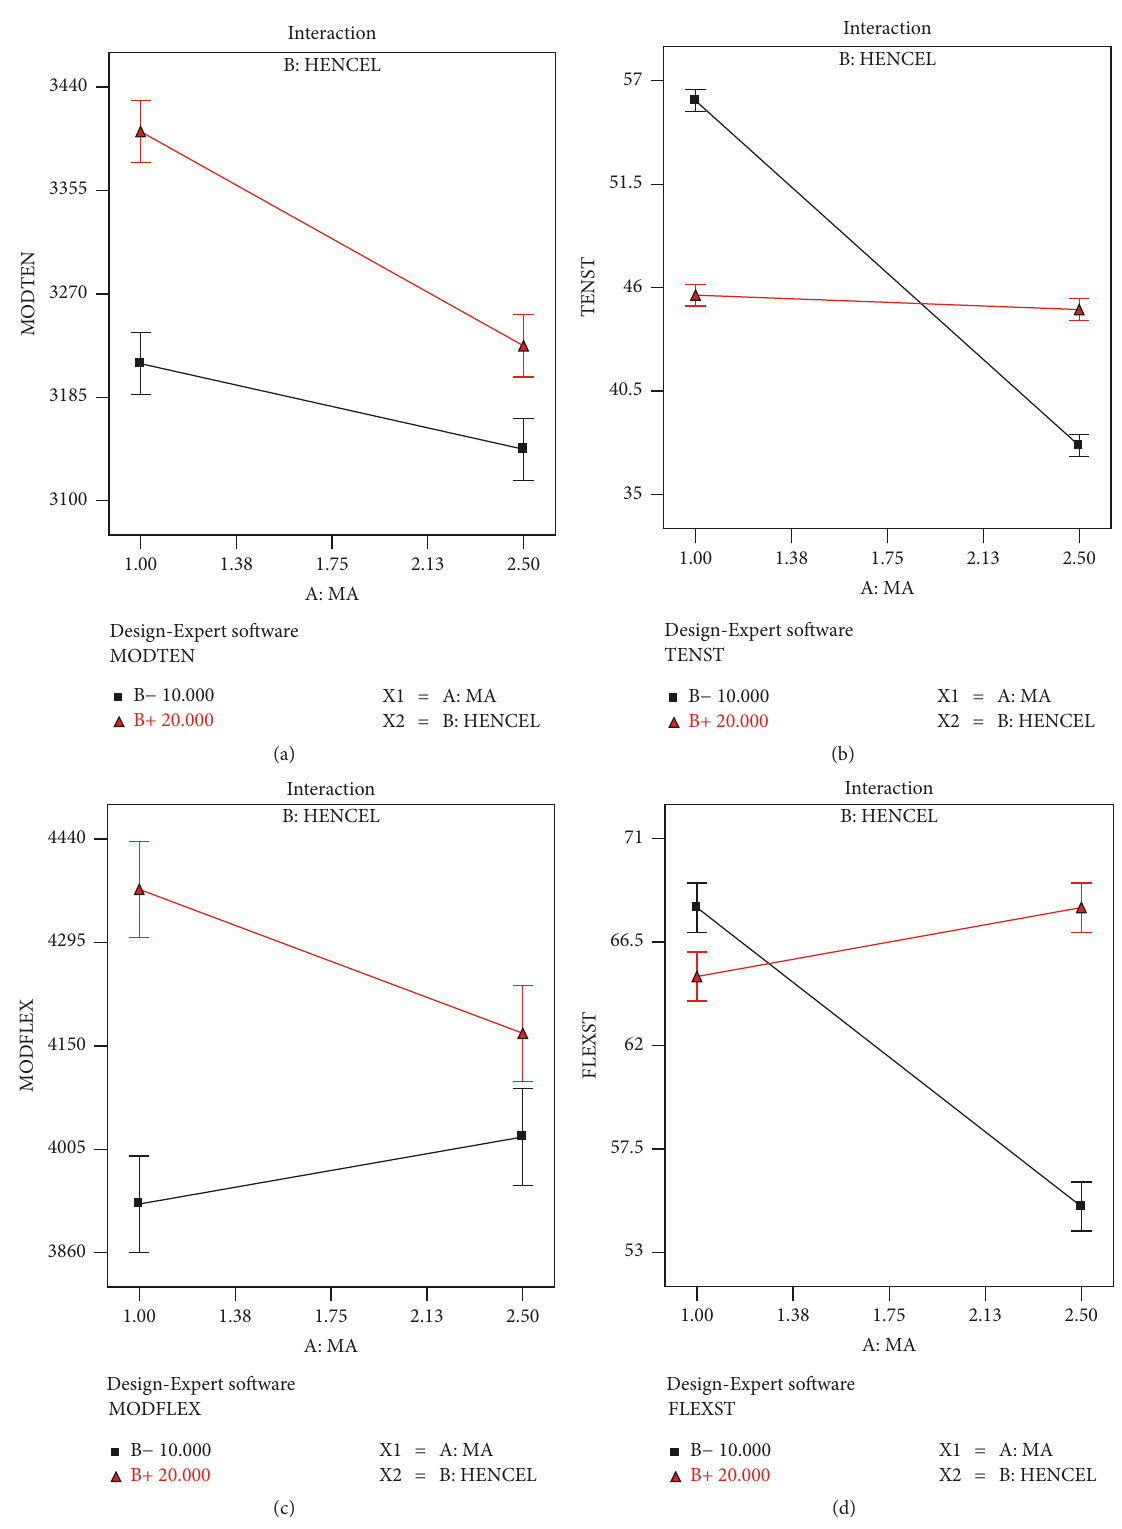
Figure 9: Interaction plots for tensile (a, b) and flexural (c, d) mechanical